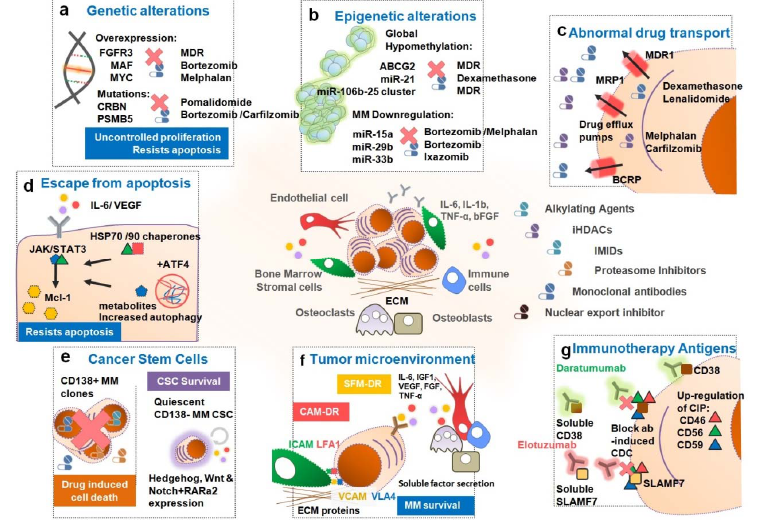
Figure 3. Mechanisms of Drug Resistance enforced by MM. ( a ) Genetic alterations such as t(4;14), t(14;16) and t(14;20) translocations, 17p and 13p deletions and c ‐ Myc associated abnormalities are associated with an unfavorable prognosis and insufficient response to current treatments. Additionally, ( b ) epigenetic alterations induced by a global hypomethylation of the DNA leads to the